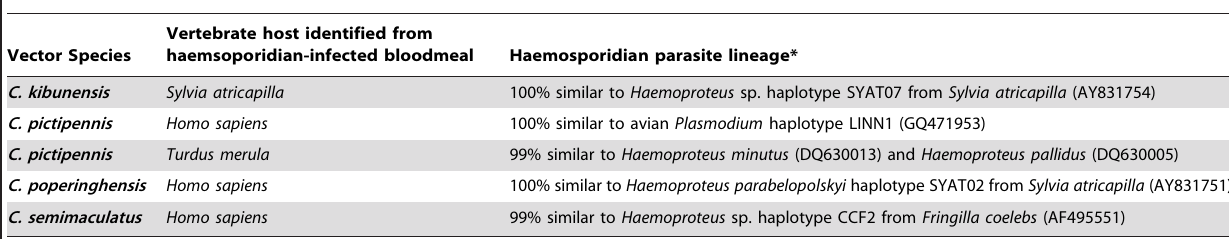
Table 2. Haemosporidian parasites found in bloodmeals from Culicoides species collected in the Mooswald forest of Freiburg.